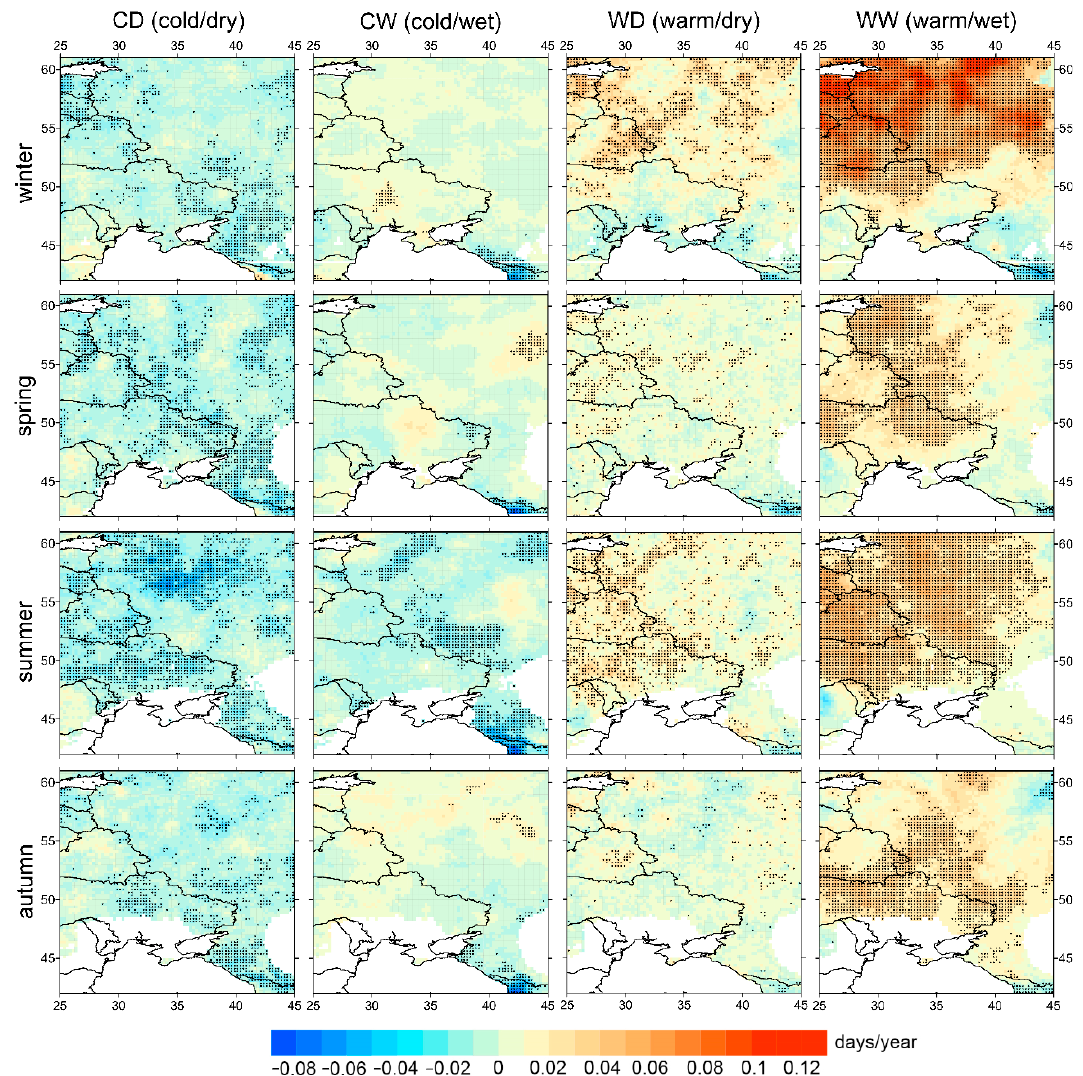
Figure 4. The spatial distribution of linear trend coefficients for compound air temperature and precipitation extremes over the period 1950–2018. Statistically significant trends ( p < 0.05) are shown as black dots.